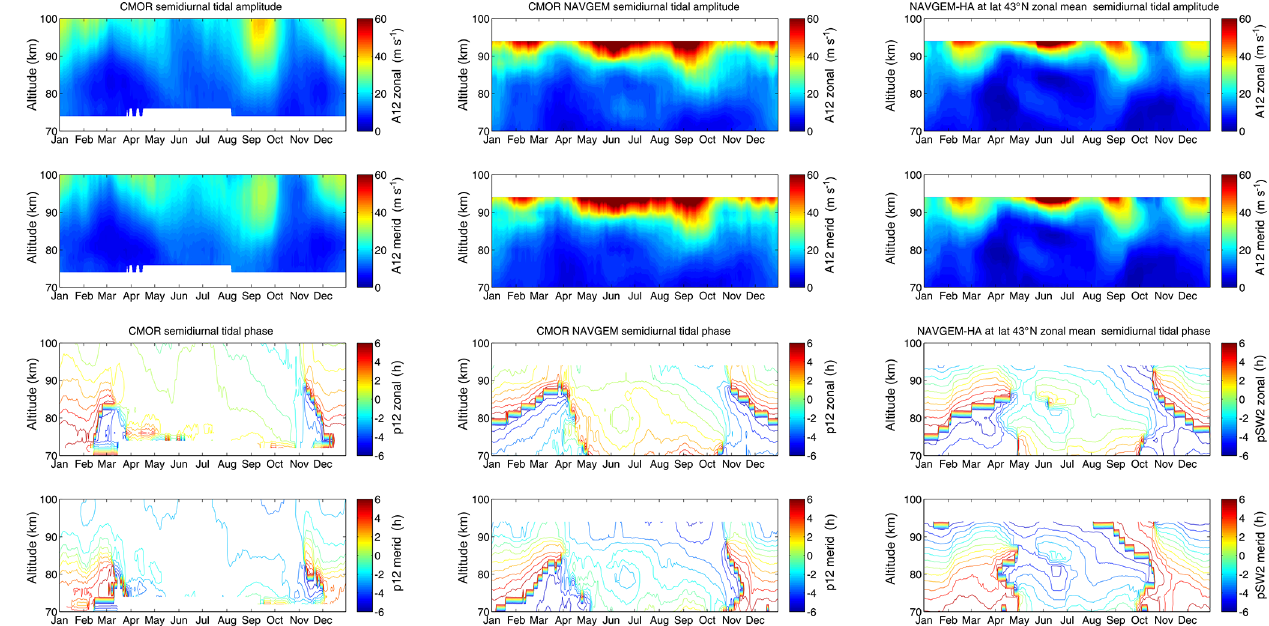
Figure 5. Same as Fig. 3 but for